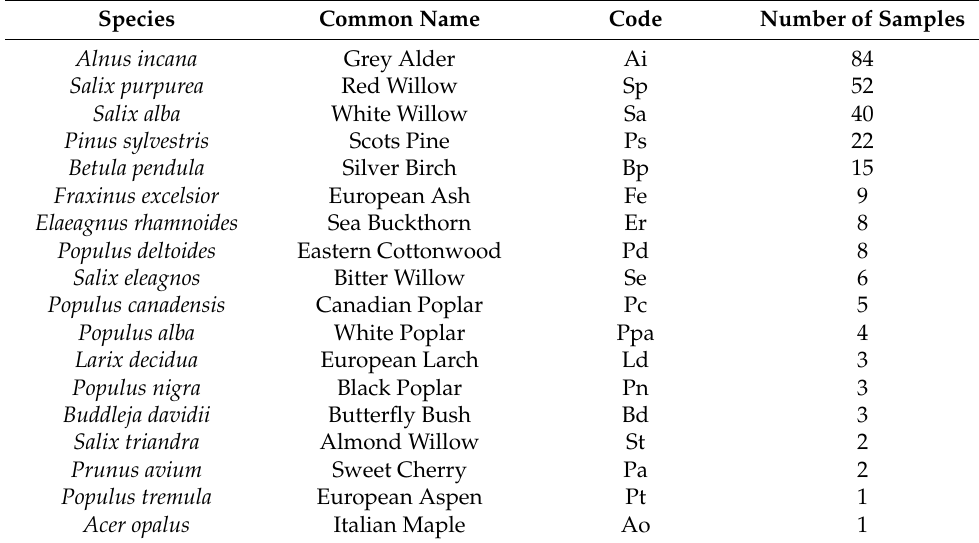
Table 4. Species mapped in the field and number of